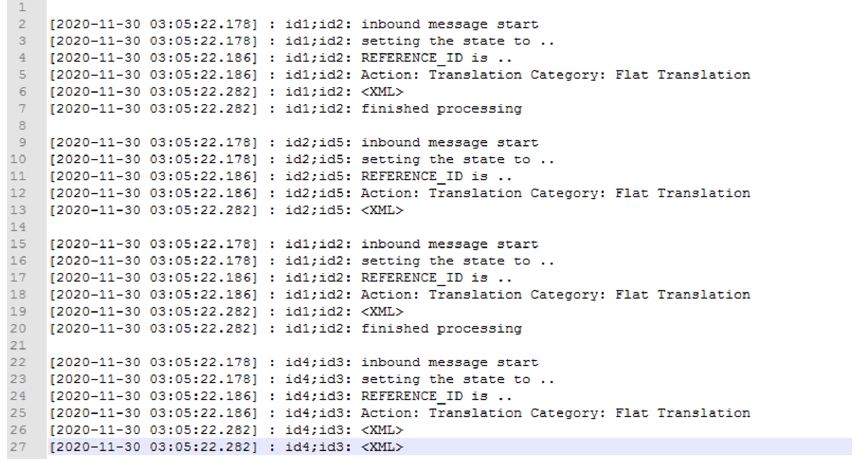
Figure 22. Log message.